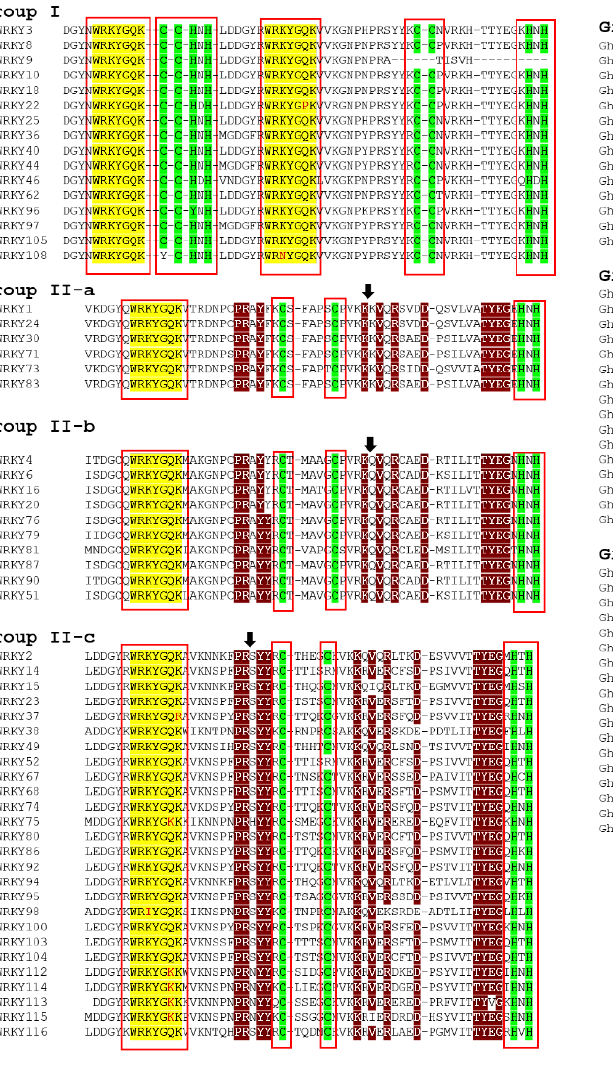
Figure 1. Multiple sequence alignment of amino acids of G. hirsutum WRKY sequences. The typical amino acids in the WRKY domain are represented in yellow color, substitutions in the WRKY domain are represented by red letters, and amino acids in the zinc finger motif are represented in green color. Maroon color represents the amino acid sequences on which classification of Group II WRKYs was performed.